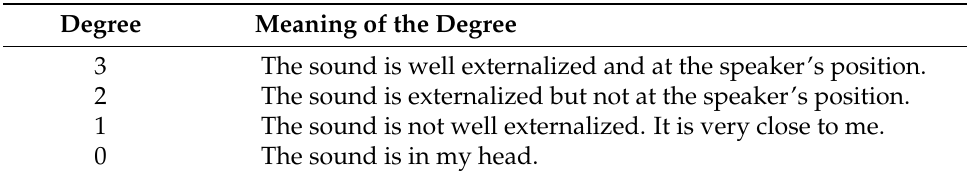
Table 1. Rating scale for perceived externalization.